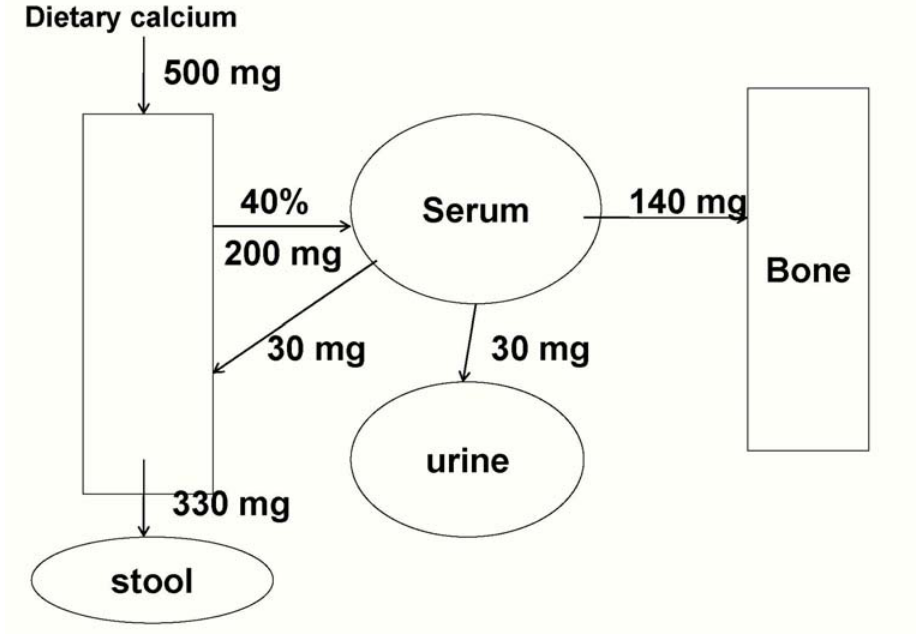
Figure 2. Calcium balance in a typical 20 kg toddler. Net calcium retention of 140 mg/day is shown as going to